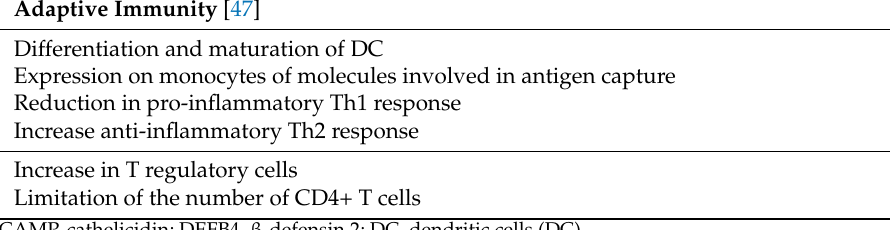
Table 2. Immunomodulating activity of vitamin D on immune systems.